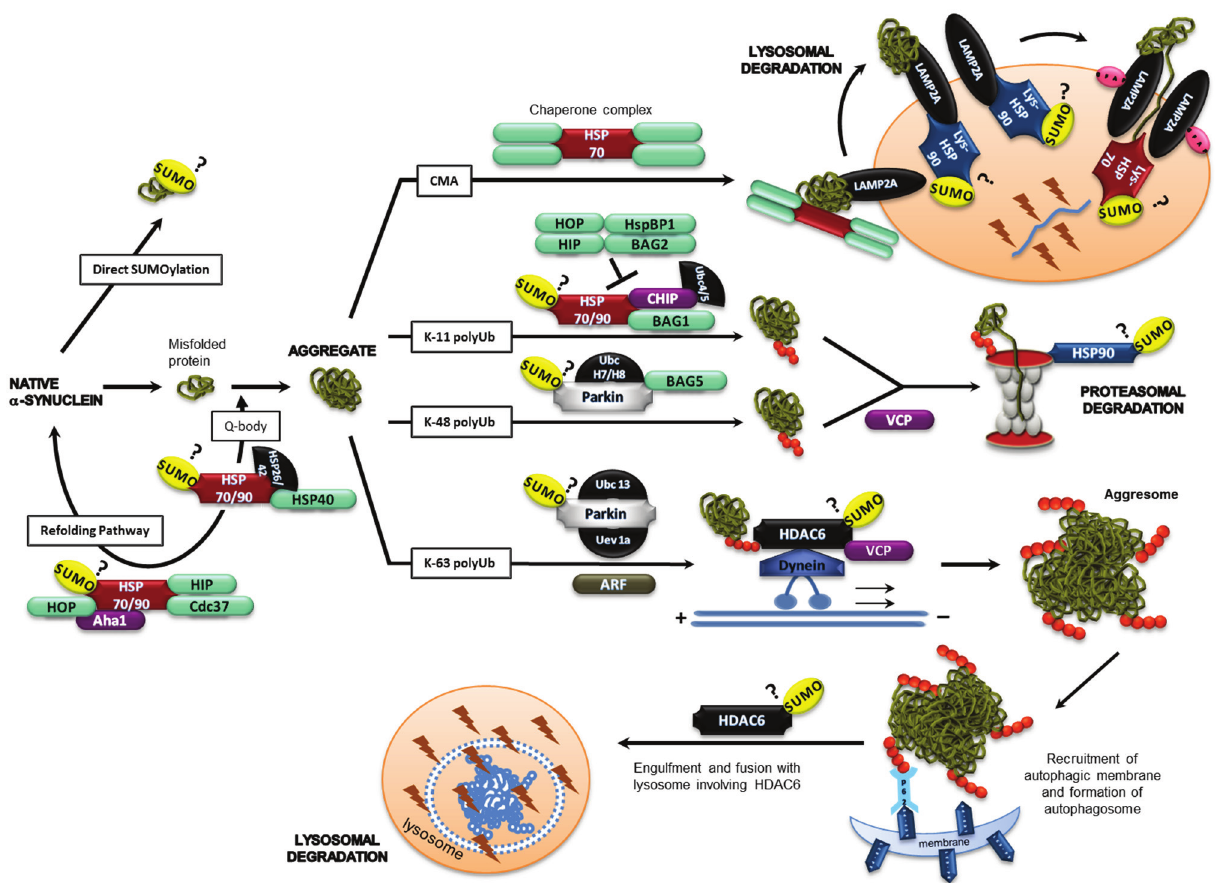
Figure 4. Mechanistic model for the role of SUMO-1 in protein misfolding. SUMO-1 post-translational modification of target proteins can modulate (cid:2)-synuclein aggregation, refolding and aggregate clearance. SUMOylation of one or more of the potential substrate proteins illustrated in a variety of cellular pathways associated with protein aggregation (Hsp90, HDAC6, p97/VCP, TRAF6, ARF, Parkin, (cid:2)-synuclein) could link SUMO-1 to the cellular response to aggregated (cid:2)-synuclein in neurodegenerative disease. See text for